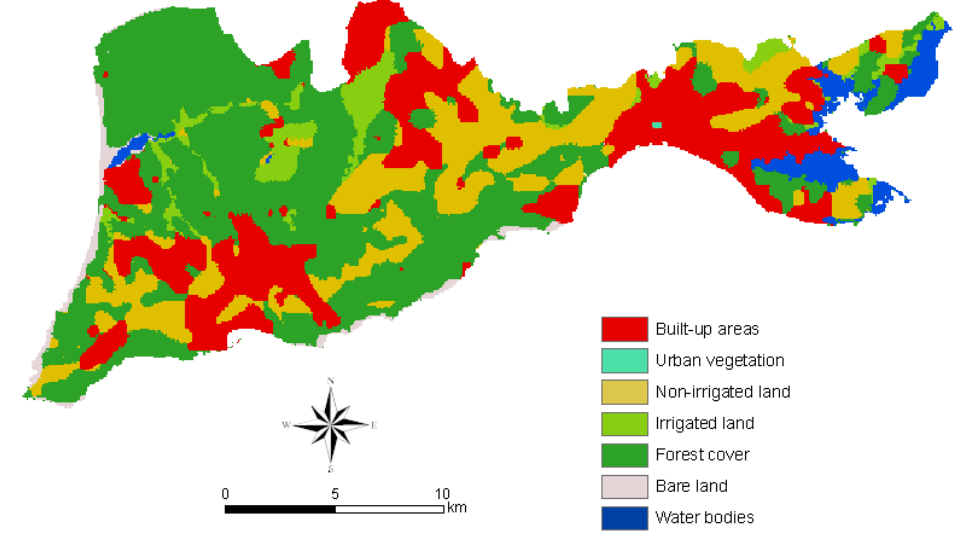
Figure 5. Simulated land cover maps for the year 2020.